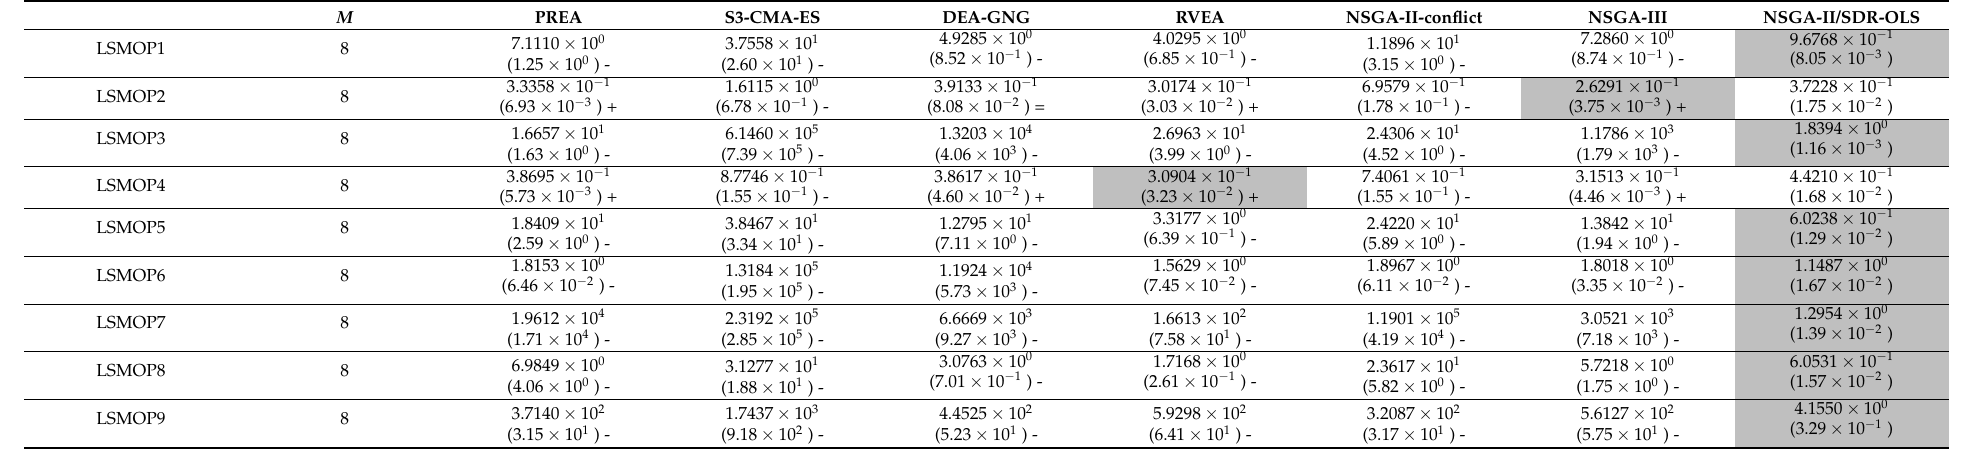
Table 10. IGD values for 9 eight-objective benchmark problems.